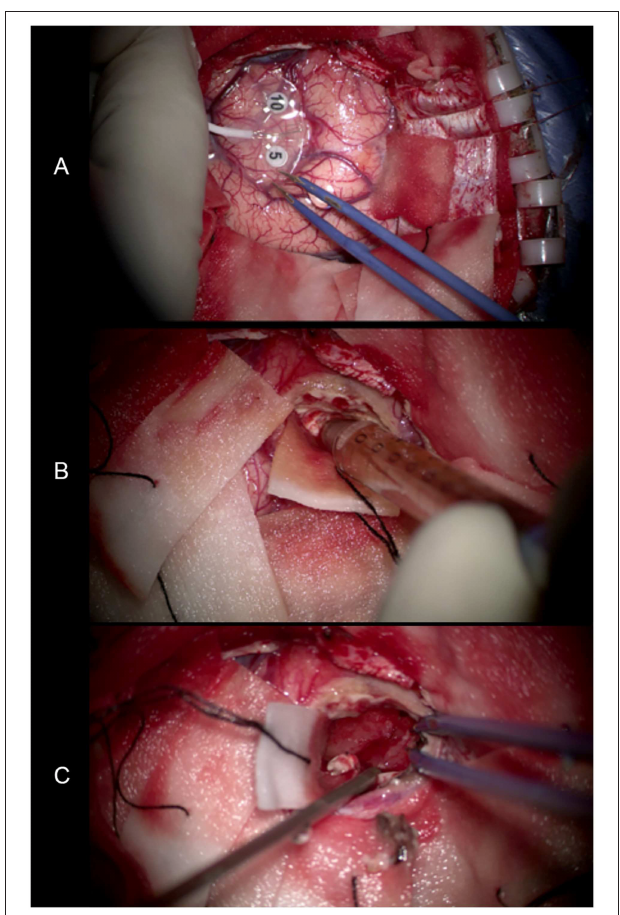
FIGURE 6 | (A) Use of an intraoperative electrophysiological monitor during surgery. Electrodes were placed on the surface of the brain to identify the functional area. (B) The pale-yellow cystic fluid suctioned by the needle. (C) The cyst wall exposed after removing the cystic fluid. It was soft and dark red in appearance.